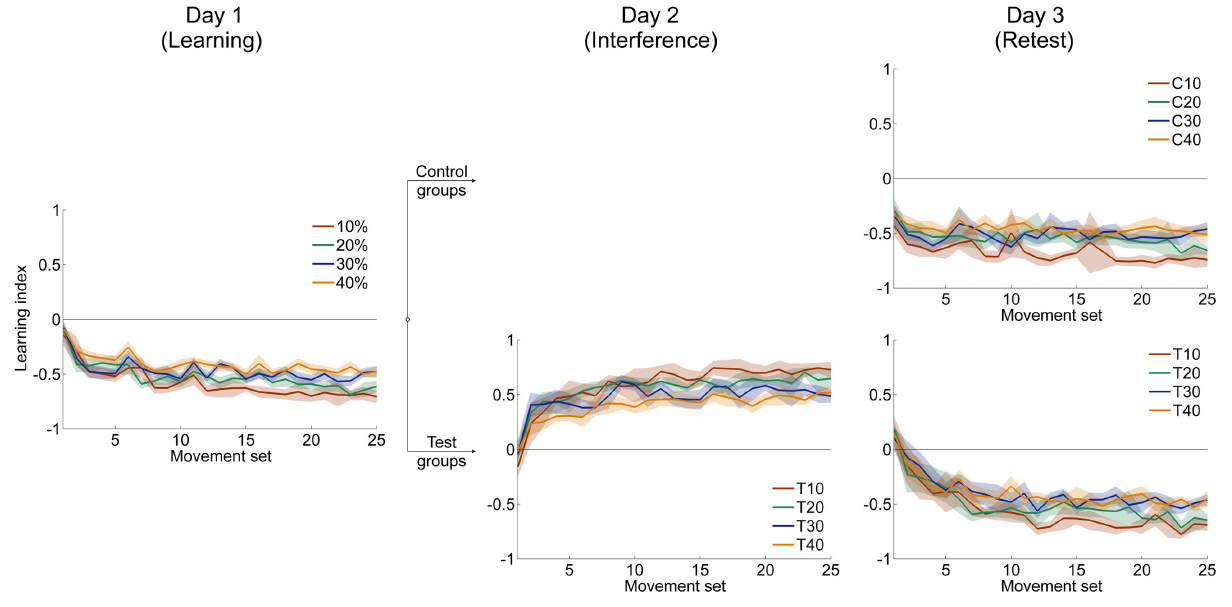
and T20 ( p = 0 . 019), T0 and T30 ( p < 0 . 001), T0 and